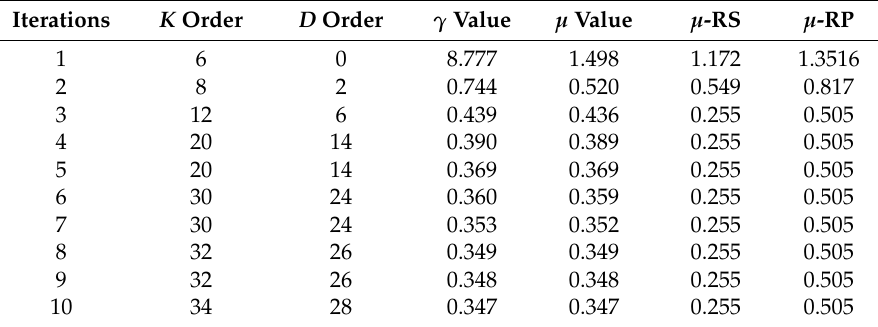
Table 2. DK iteration results.